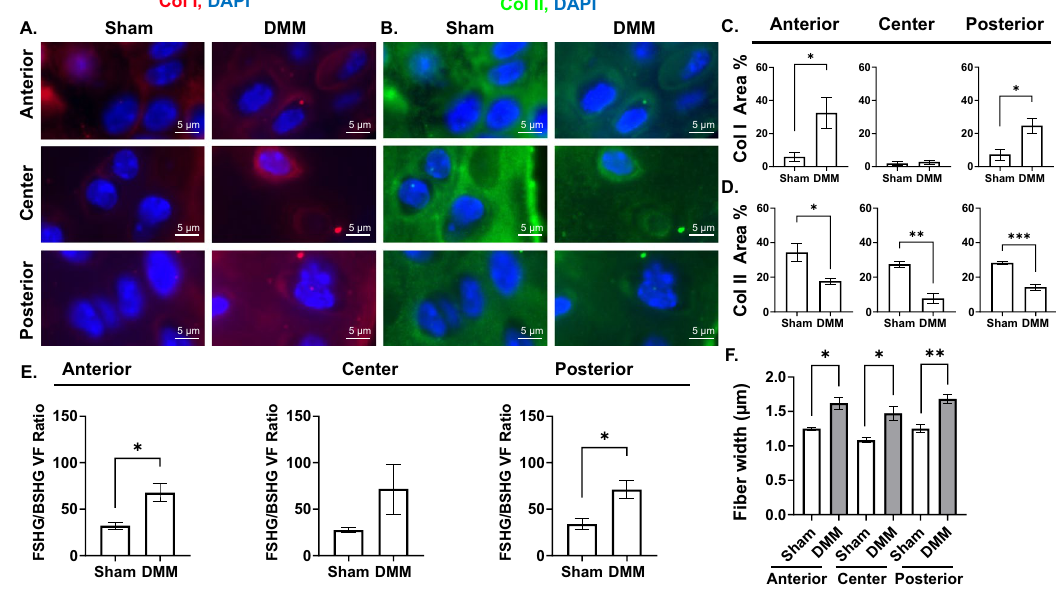
Figure 2. OA results in changes to collagen content, fiber width, and organization in the articular cartilage. ( A ) Immunofluorescence (IF) staining for Col I and ( B ) Col II expression in anterior, center, and posterior regions of articular cartilage, (× 40 magnification, scale bar = 5 μm, images acquired with Zeiss Zen Blue 2.6 edition software). Quantification of area percentage (area of positive signal normalized to total selected area) of ( C ) Col I and ( D ) Col II IF stains. ( E ) Volume fraction (volume producing SHG signal in the selected ROI normalized to the total volume) ratio between FSHG/BSHG VF in ROIs of articular cartilage. ( F ) Comparison of FSHG fiber width (μm) between sham and DMM samples in each ROI. * P < 0.05, ** P < 0.01, *** P < 0.001 using unpaired t-test with Welch’s correction, values are expressed as mean ± SEM; 3 images were analyzed per ROI in each sample, N =